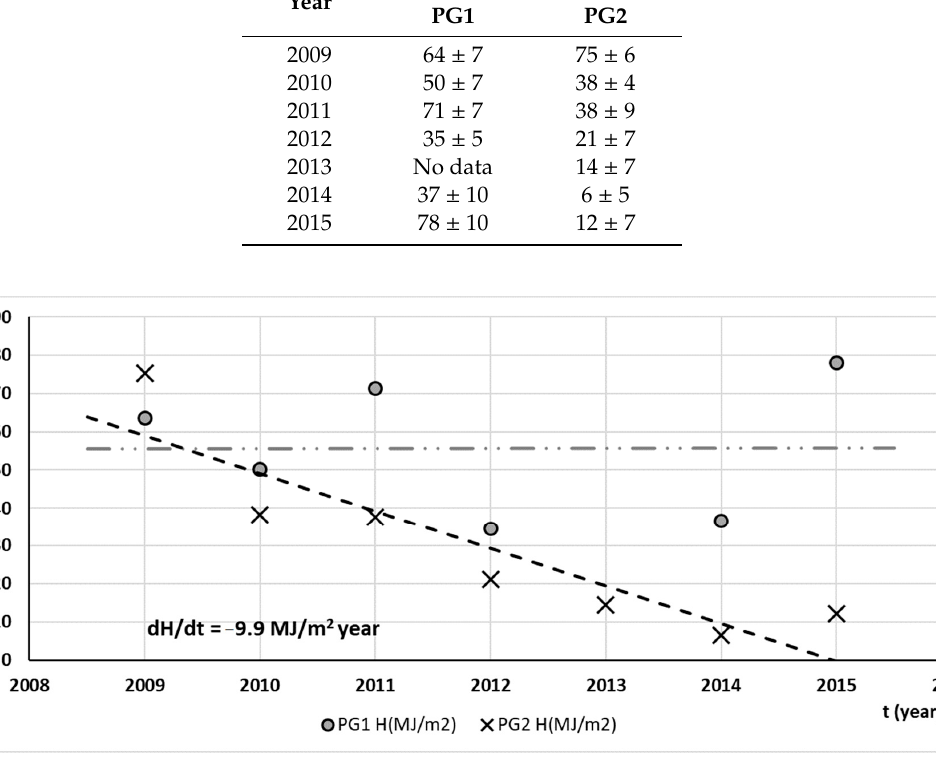
Figure 6. Soil surface energy exchange in PG1 and PG2 from 2009 to 2015 (note that there are no data in PG1 for 2013). Table 6. Annual integration of soil surface energy exchange (H) for PG1 and PG2 boreholes.